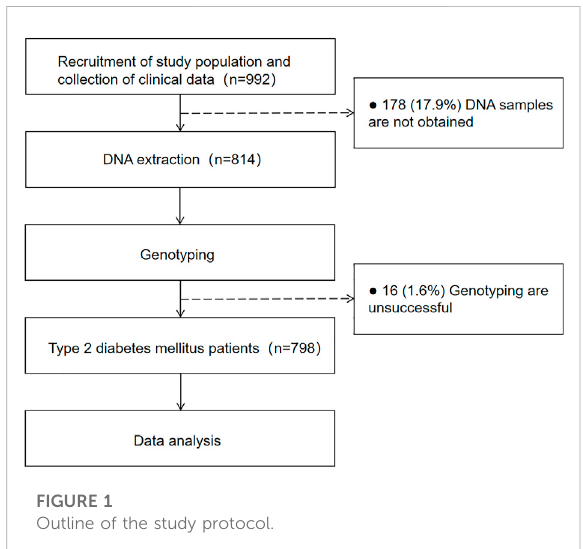
FIGURE 1 Outline of the study